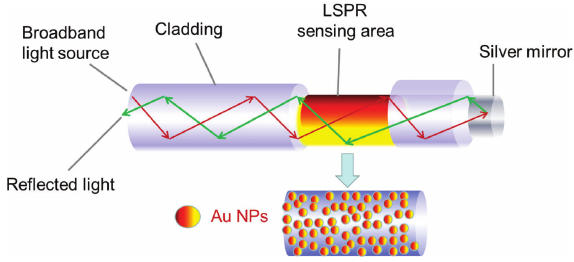
Figure 1: Schematic illustration of fiber-optic LSPR sensing